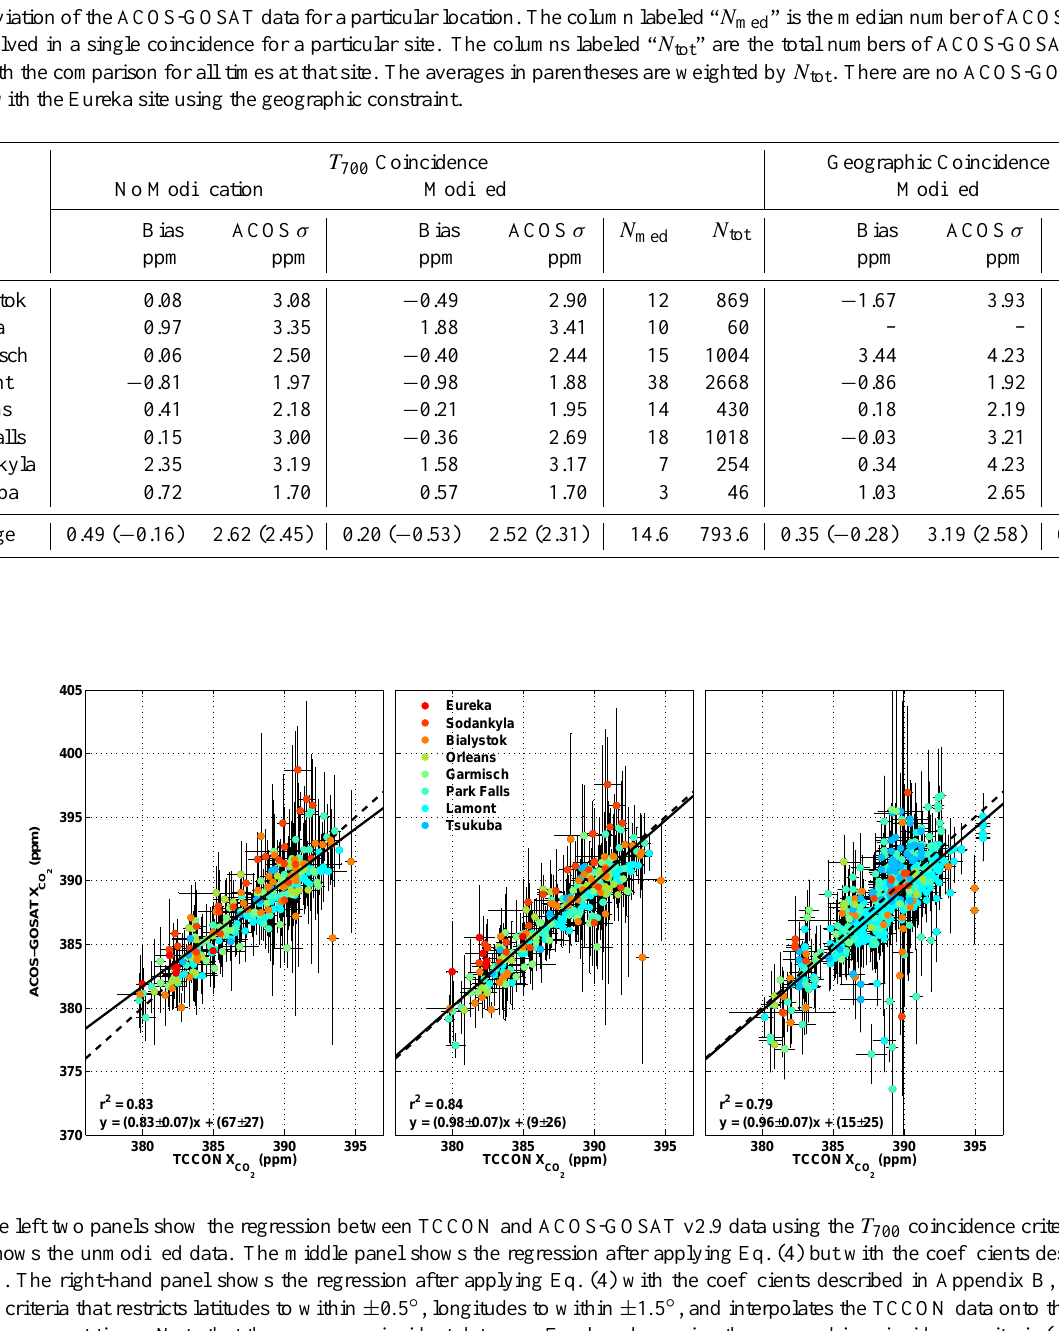
and the ACOS-GOSAT X CO 2 2 from the ACOS-GOSAT X CO . The “No Modification” fields 2 2